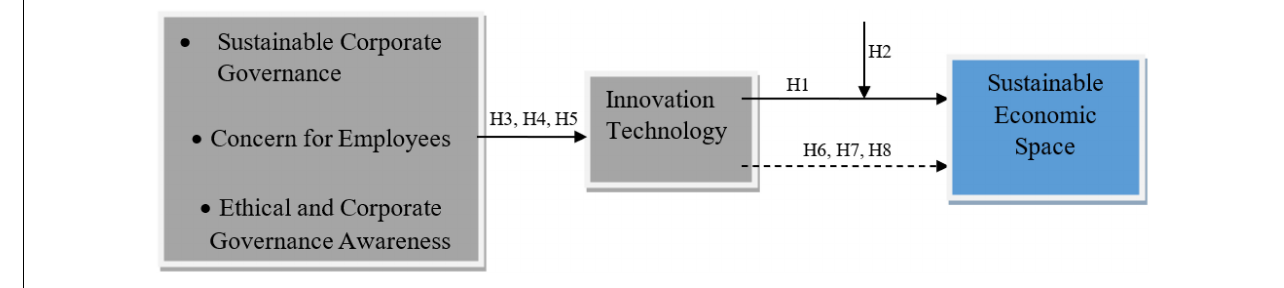
FIGURE 1 | Conceptual